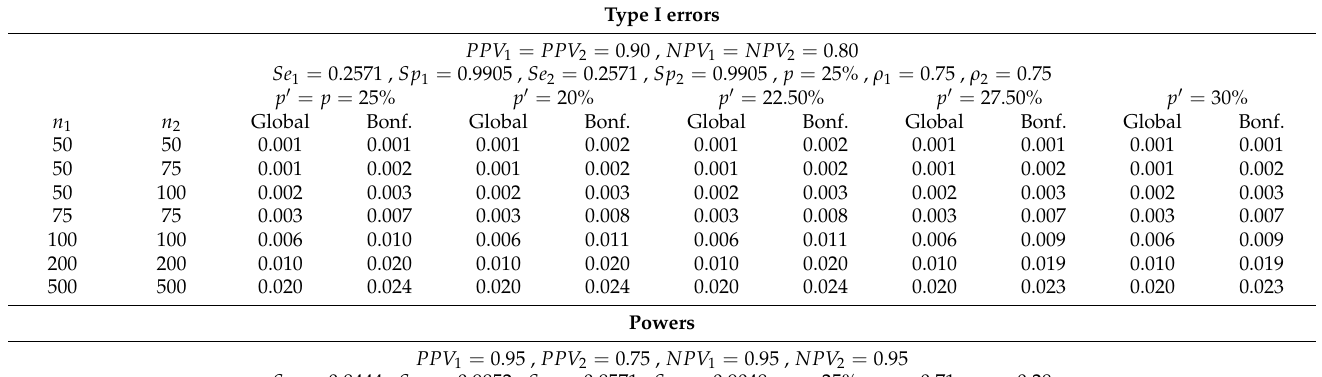
Table 8. Effect of a misspecification of the prevalence. Type I